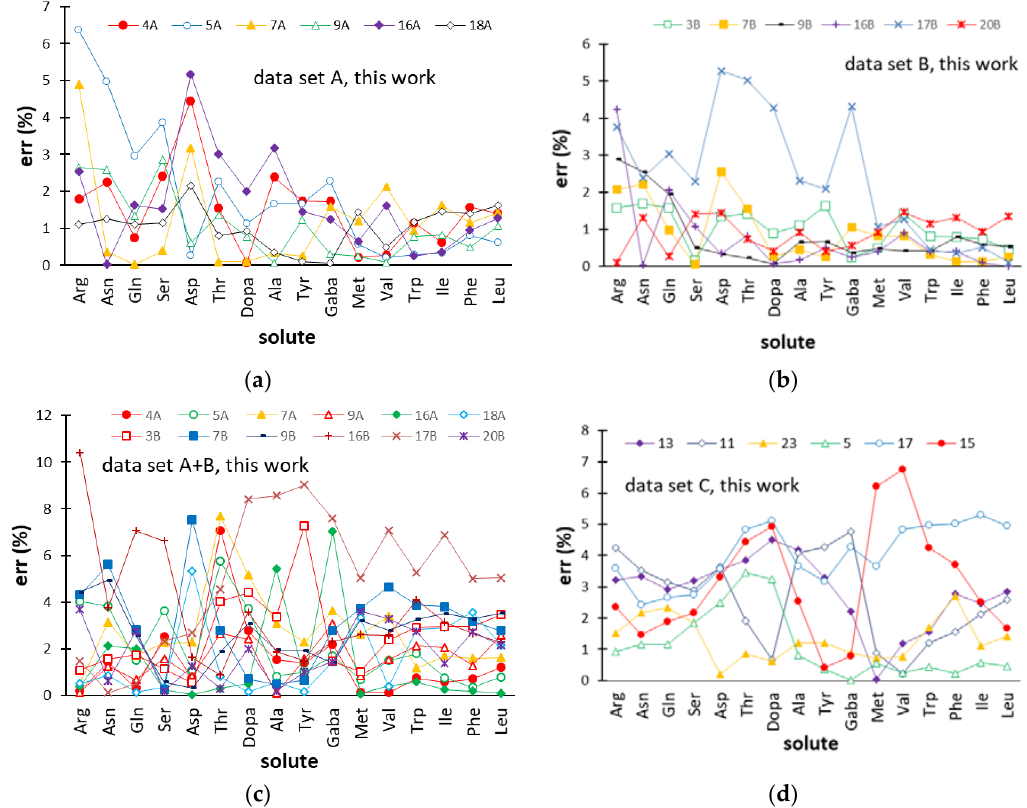
Figure 3. Percentage errors (err (%)) for the retention times of the amino acids provided by the ANN-based models in the external gradients (test set) of datasets A ( a ), B ( b ), A+B ( c ), and C ( d ). Abbreviations used for the amino acids are reported in Section 3.1. Gradient codes are specified in